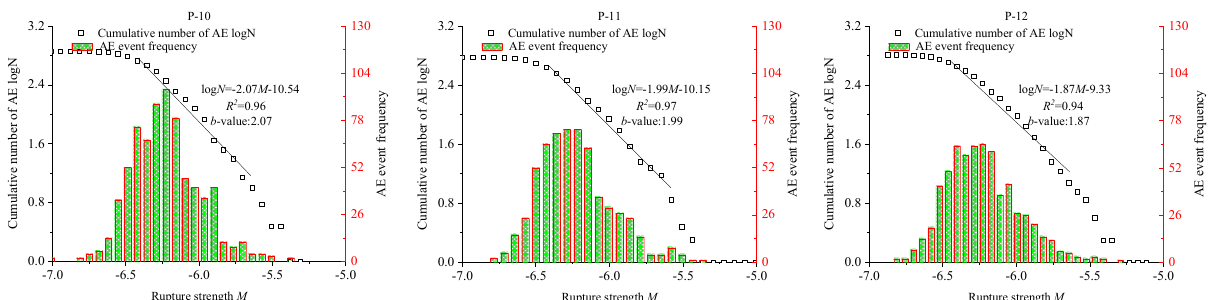
Figure 16. Frequency–amplitude curve and b value.